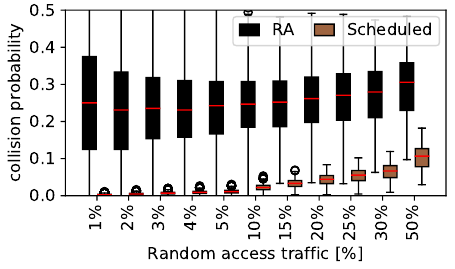
Figure 8. Collision by access